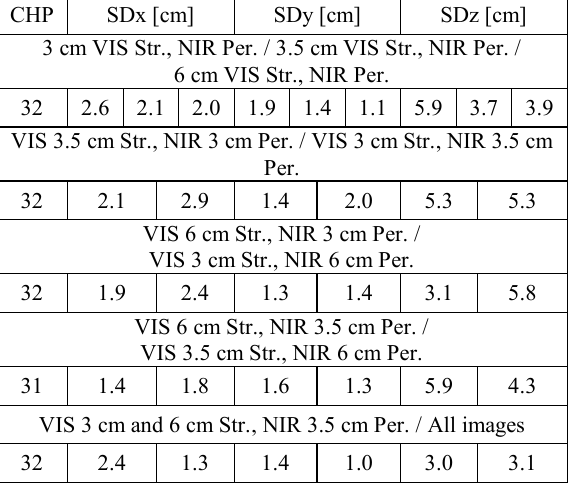
Table 12. Estimated standard deviations between RTK GNSS and RPAS method